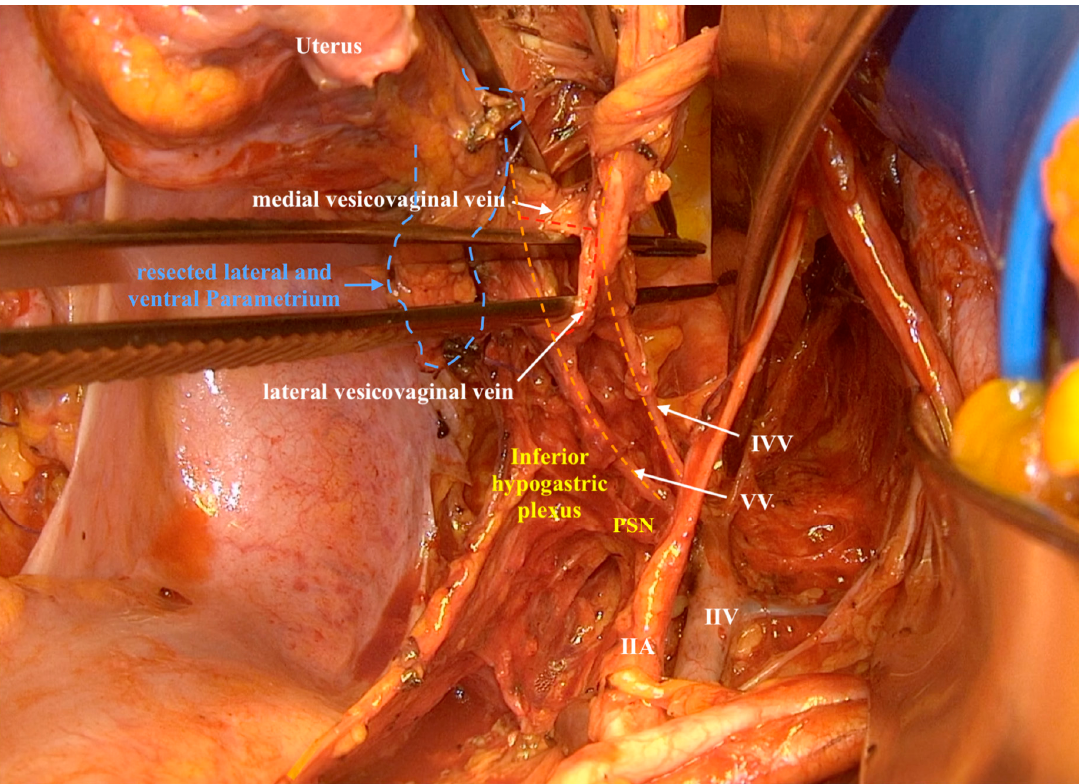
Figure 3. The lateral and ventral paracolpium with the vesicovaginal veins in the ventral paracolpium and their connection to the inferior vesical vein. VV: vaginal vein, IVV: inferior vesical vein, IIA: internal iliac artery, IIV internal iliac vein, PSN: pelvic splanchnic nerves. iliac artery, IIV internal iliac vein, PSN: pelvic splanchnic